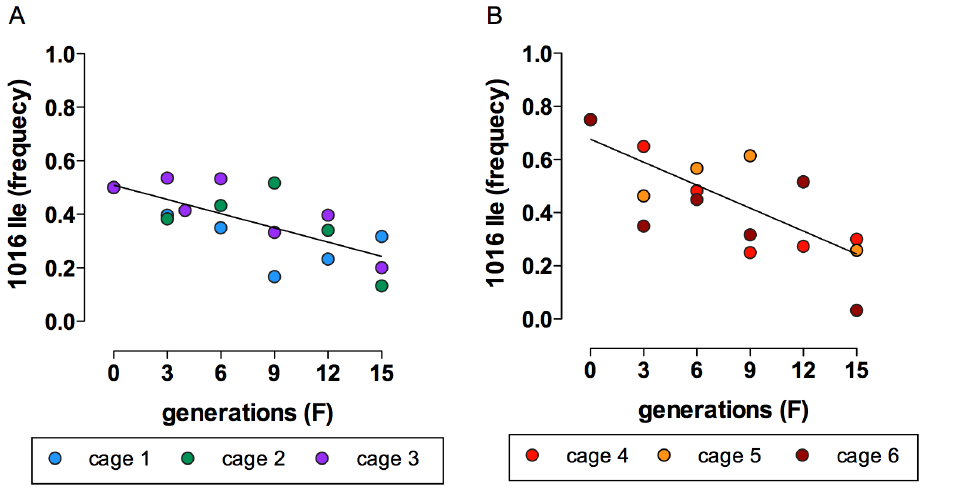
Figure 7. Population cage assays with pyrethroid resistant Aedesaegypti (Rock-kdr) and Rockefeller strains. The frequency of AaNa V alleles in the 1016 site was followed in independent cages kept under the same conditions, without insecticide exposure for 15 generations. The initial frequency of the 1016Ile kdr allele in cages 1–3 (A) was 0.50 and in cages 3–6 (B) was 0.75. Lines represent the linear regression analysis taken by the means of the mutant allele frequencies of the respective three cages in A (r 2 =0.5273, p=0,0006) and B (r 2 =0,5690, p=0,0003).